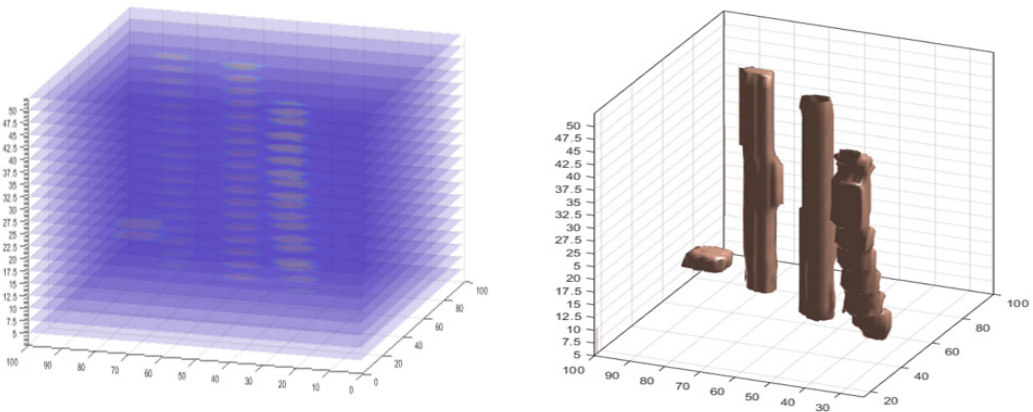
Figure 8. Stacking 2D slices to create a 3D model.